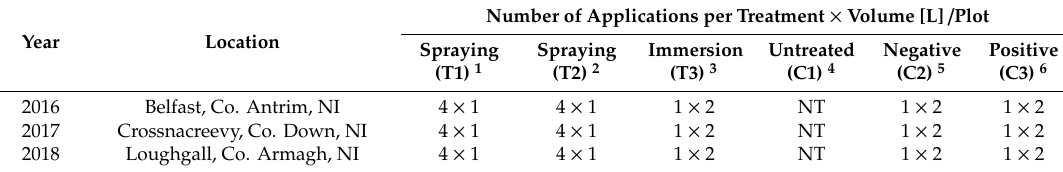
Table 1. Details of field trials performed in years